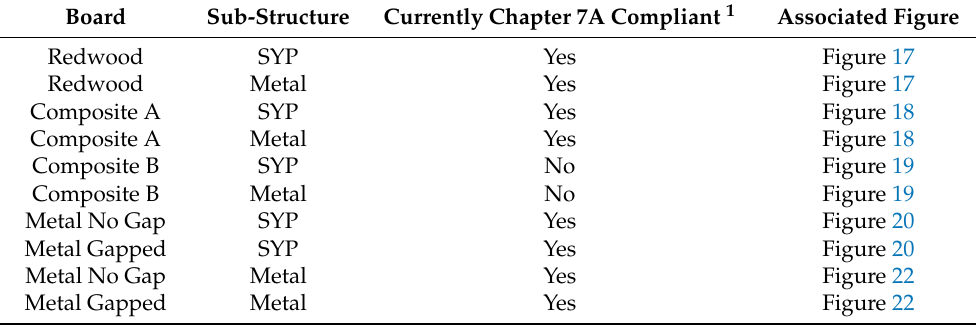
Table 2. Summary of the under-deck flame-impingement tests.